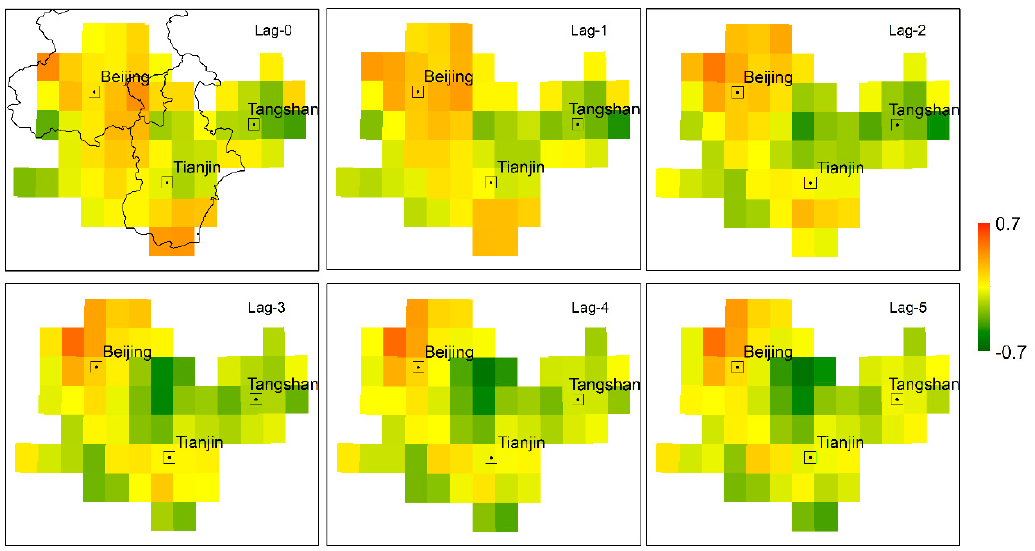
Figure 9. 0–5-month lag correlation fields between the urban induced enhancement of precipitation (UIEP) and Niño3.4 in the region of interest (ROI).